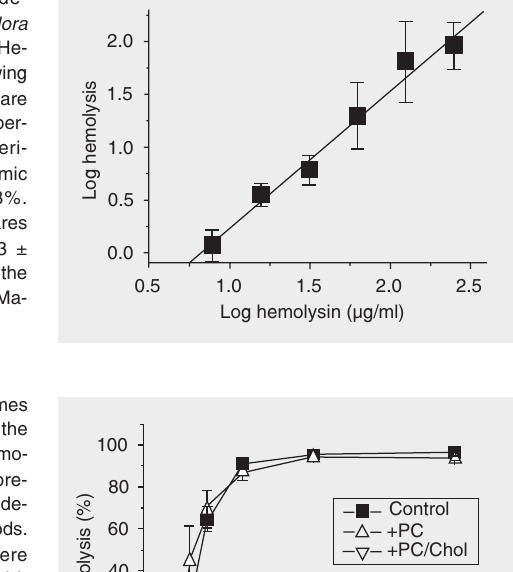
and the erythrocyte suspension was then added. Hemolysis was quantified following incubation for 1 min. Data are reported as mean ± SD percent hemolysis for 4 experiments. Squares, tri- angles, and inverted triangles show the effects of untreated hemolysin, and of hemolysin pre-incubated with phosphatidylcholine (PC) liposomes and PC/cholesterol (Chol) lipo- somes, respectively. All other conditions for the experiment are described in Material and Methods. Figure 5. Typical recordings of transmembrane current under the influence of the hemolysin. Hemolysin (final concentration: 20 µg/ml) was added to the cis- compartment at the time indi- cated by the arrow. Planar bi- layers were formed from pure phosphatidylcholine (PC) (A) or from a PC/cholesterol mixture (1:1; w/w) (B) by the method of Mueller et al. (29). Current and time scales are given in the fig- ure. Other conditions are de- scribed in Material and